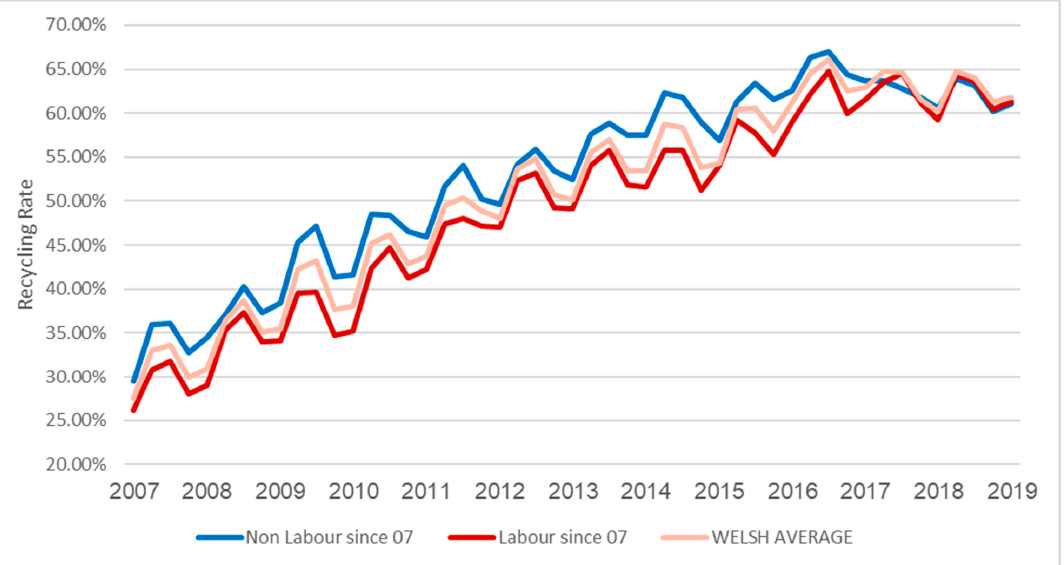
Figure 9. Recycling rate of local authorities (LAs) that have/have not been held by the Labour Party since 2007. Source: WasteDataFlow.